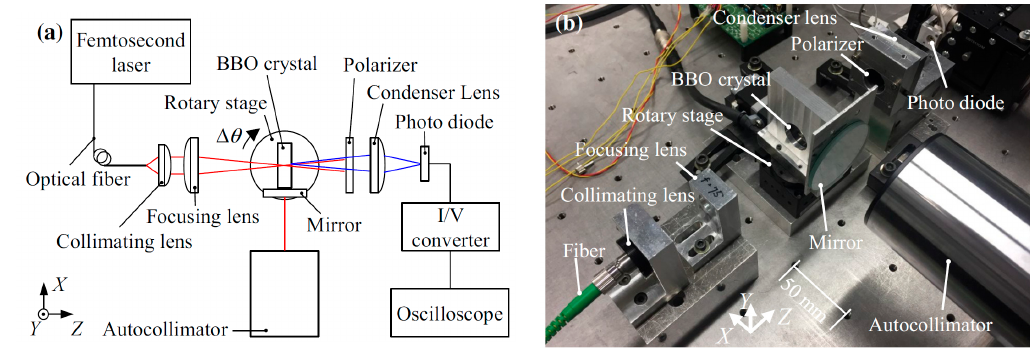
Figure 18. Measurement of the angular displacement of a rotary table based on SHG: ( a ) Optical configuration of the setup; ( b ) A photograph of the setup [59].